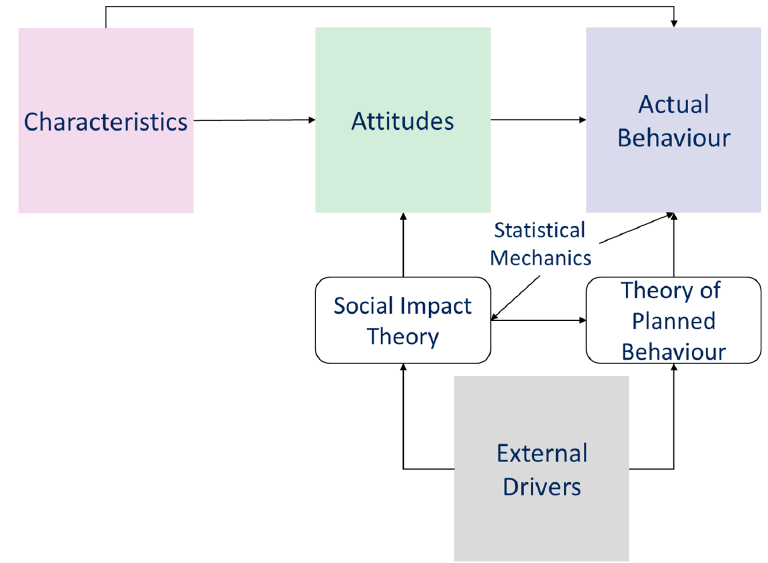
Figure 2. Domestic water demand shaping factors in urban water agents' behavior (UWAB).